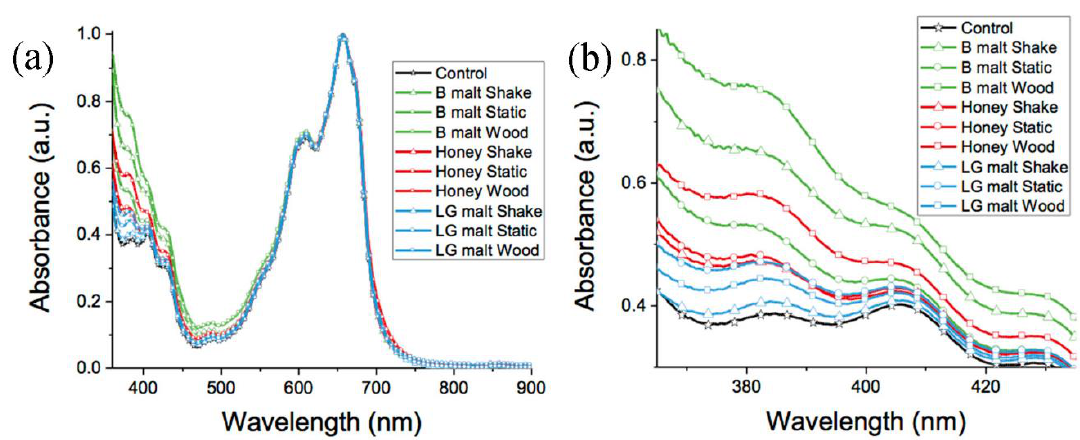
Figure 7. Xylindein extract from C. aeruginosa (UAMH 11657) absorption across growth conditions. Control sample was ethanol-washed solidified xylindein. ( a ) Absorbance of extracted pigment solutions showing characteristic xylindein peak at ≈660 nm and variation in absorbance at shorter wavelengths due to varying concentration of non-xylindein interferents known to reduce electronic properties. ( b ) Close up absorbance around 400 nm, where largest variation was seen in terms of other interfering compounds in solution. Higher absorbance is associated with higher concentrations of contaminants, with lab-grade shaking cultures showing lowest contamination.